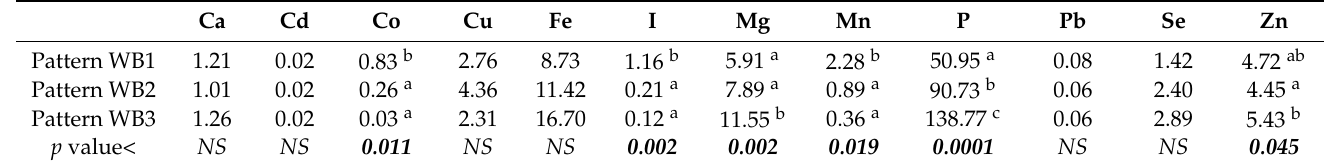
Table 14. Mean values of minerals in camel whole blood based on Ascending Hierarchical Classifica- tion patterns [ µ